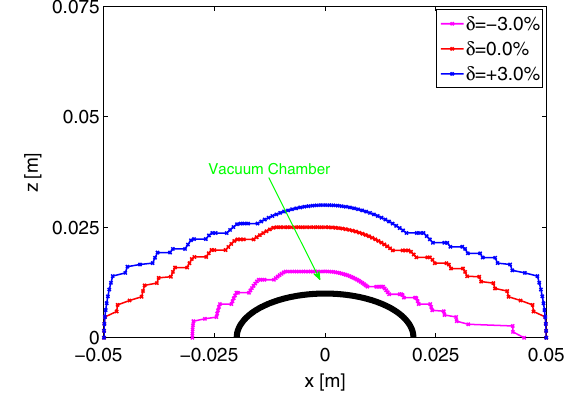
FIG. 5. The dynamic aperture at the center of one of the short straight sections for the particles with three different momentums. The black half-ellipse shows the cross section of the vacuum chamber at this position.